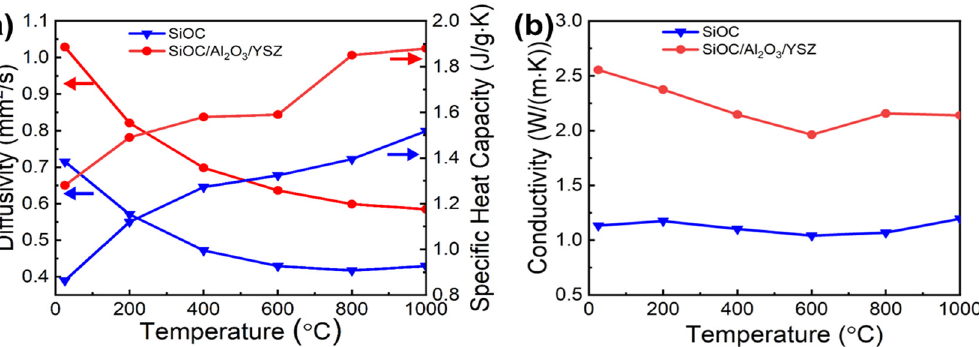
Figure 6. Thermal properties of the SiOC ceramic and the SiOC/Al 2 O 3 /YSZ ceramic as a function of temperature: ( a ) thermal diffusivity and specific heat capacity, ( b ) thermal conductivity.